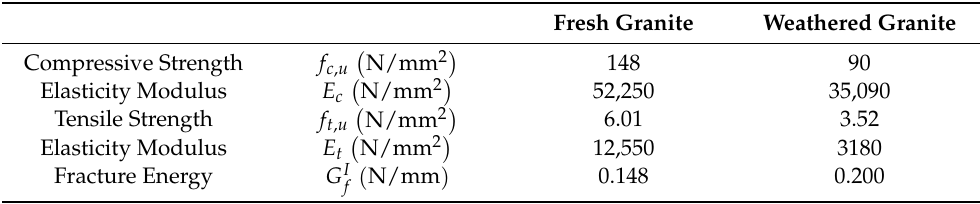
Table 1. Uniaxial mechanical properties of granite stone units.